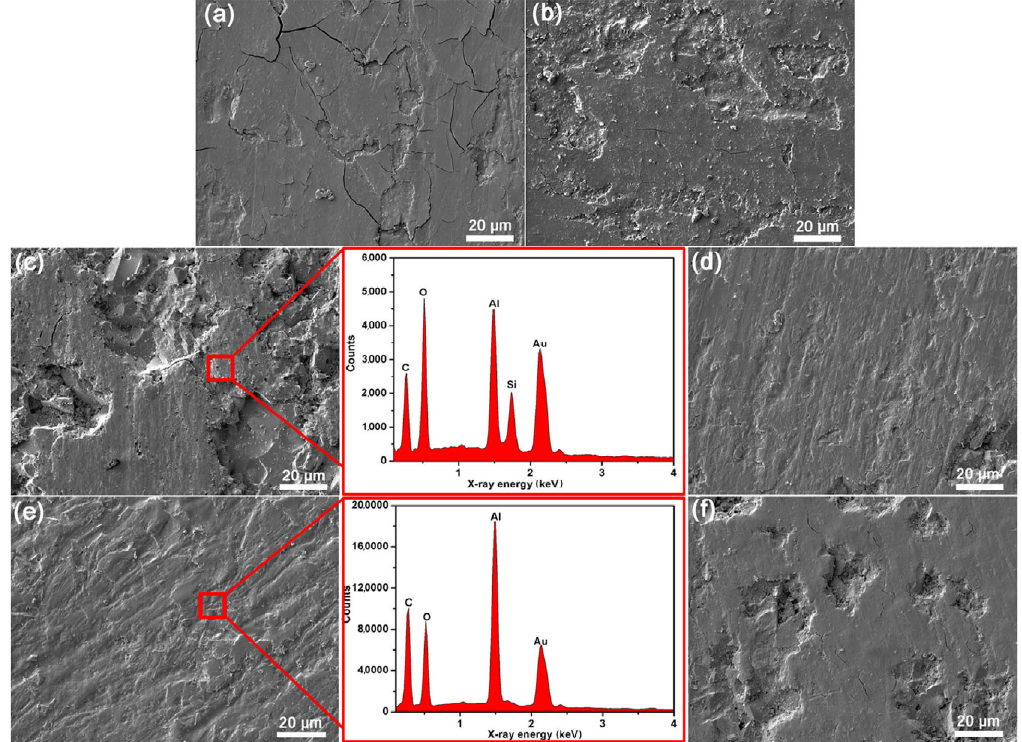
Fig. 13 Tribofilms formed on the Al 2 O 3 surface after rubbing with (a, b) PI/SCF, (c, d) PI/SCF/SiO 2 , and (e, f) PI/SCF/BN at 4 and 8 MPa·1m/s. The results of EDS analysis of the red squares in (c) and (e) are shown on the